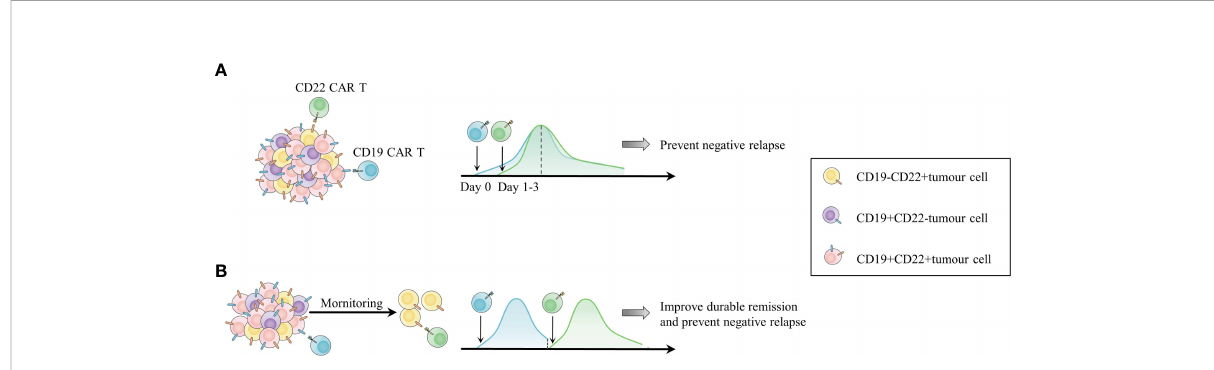
FIGURE 4 Two combinations of CD19 and CD22 CAR T cell products as an example of combinations among different types of CAR T cells. (A) Cocktail infusion of CD19 and CD22 CAR T cells for addressing antigen-negative relapse. (B) Sequential infusion of CD19 and CD22 CAR T cells according to the in vivo activity of CAR T cells and patient status to overcome both short duration and antigen